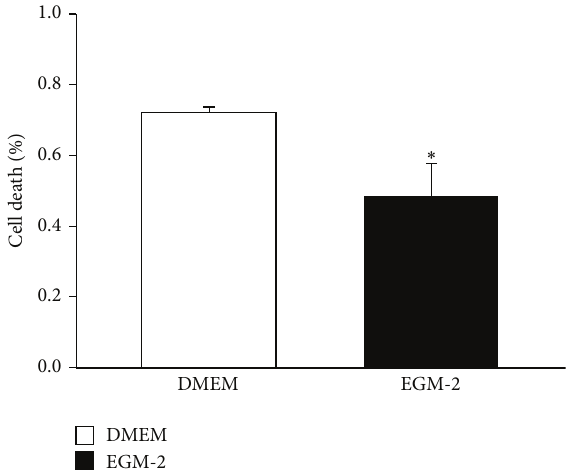
Figure 2: Cell Death. Percentage of dead cells that are positive for both Anexin V and propidium iodide in the population of cells cultured on conventional medium (DMEM) or stimulated with EGM-2 (EGM-2). Values indicated as the mean ± sem. ∗ 𝑝 < 0.05 vs DMEM group. ( 𝑛 = 5 for both groups).